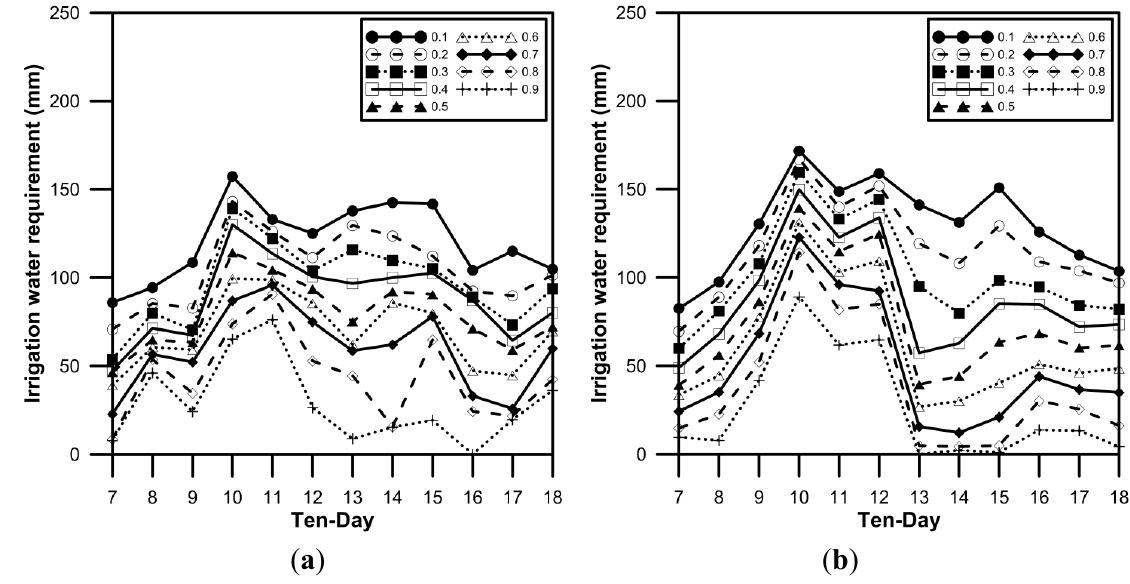
Figure 17. Exceedance probability distribution of irrigation water requirement at each ten-day during the first cropping season. ( a ) present (2004–2011); ( b ) future (2046–2065).